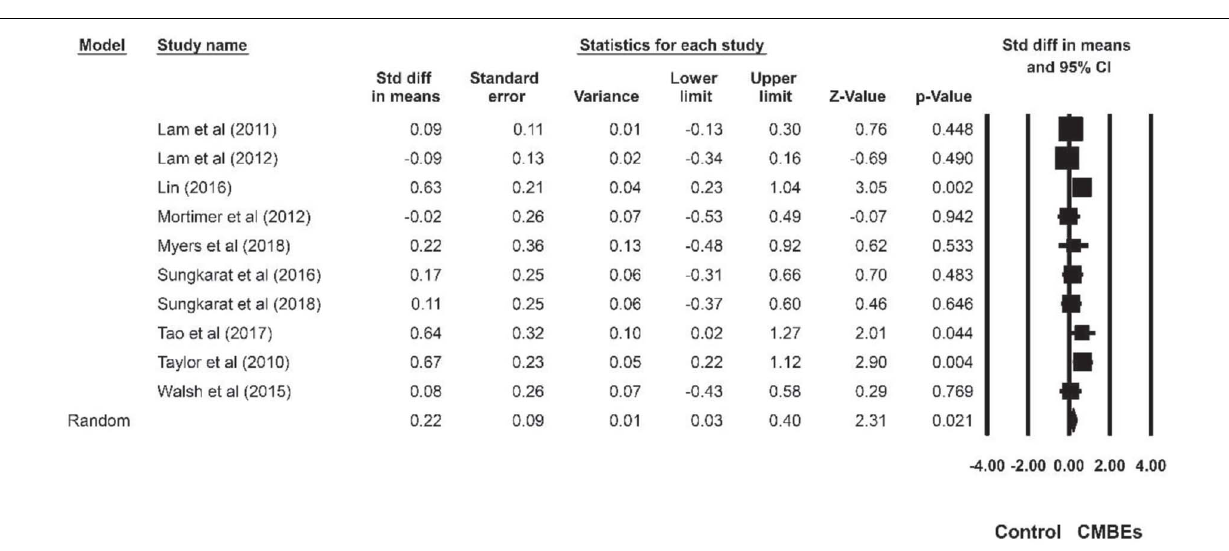
FIGURE 5 | Forest plot of Chinese mind-body exercises on working